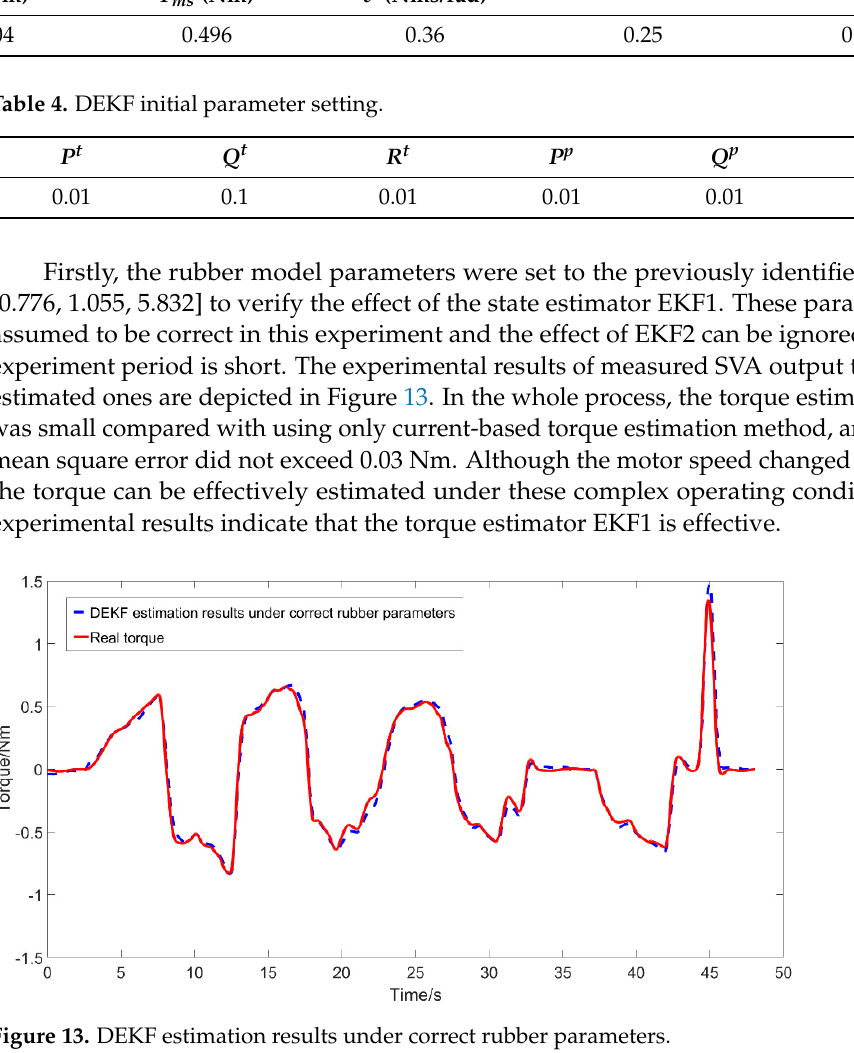
Figure 13. DEKF estimation results under correct rubber parameters.